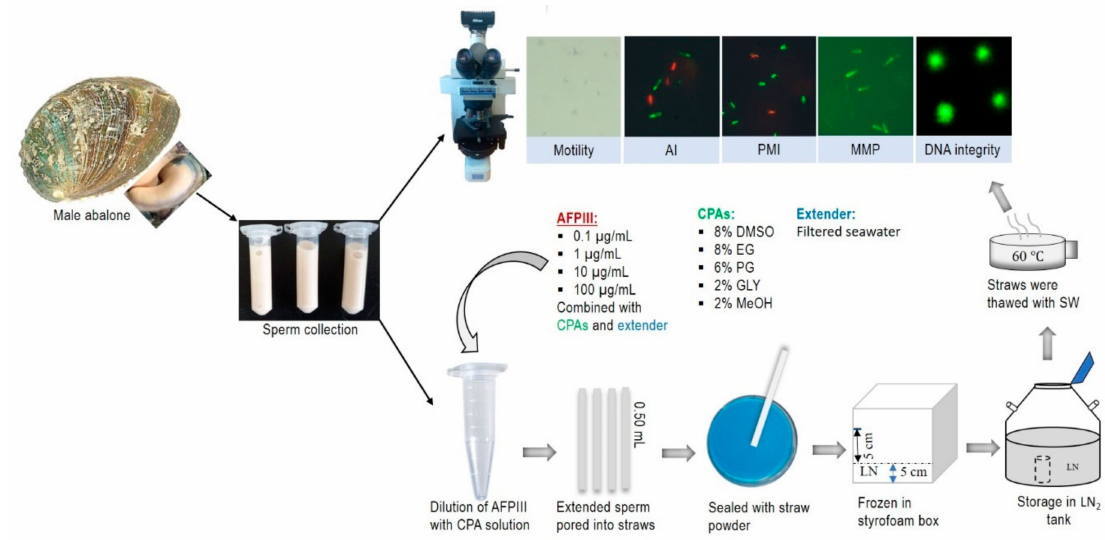
Figure 9. Diagrammatic presentation of the sperm cryopreservation protocol of Pacific abalone, H. discus hannai , using an antifreeze protein III